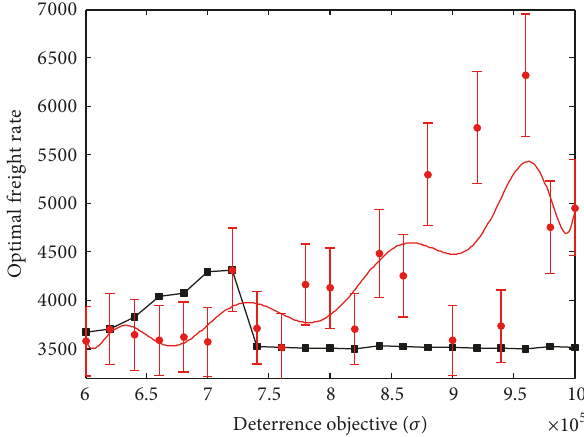
Figure 8: The basic freight rate for two carriers varying with the deterrence objective. Black square for carrier 1 (shipping); red circle for carrier 2